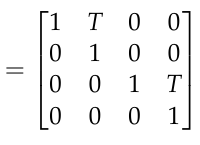
algorithm proposed in Section 2.2 for target trajectory clustering, the approximate